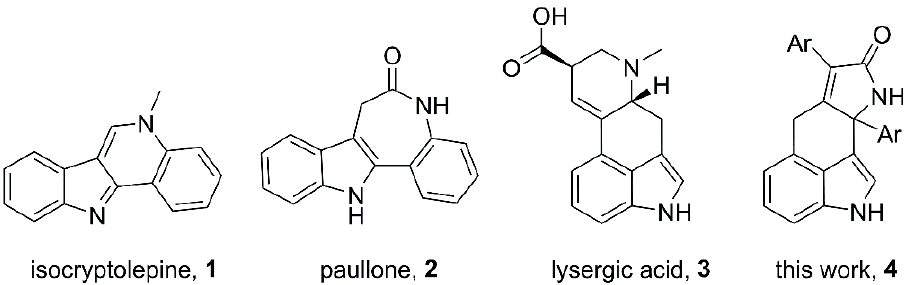
Figure 1. Examples of some polycyclic indole alkaloids.